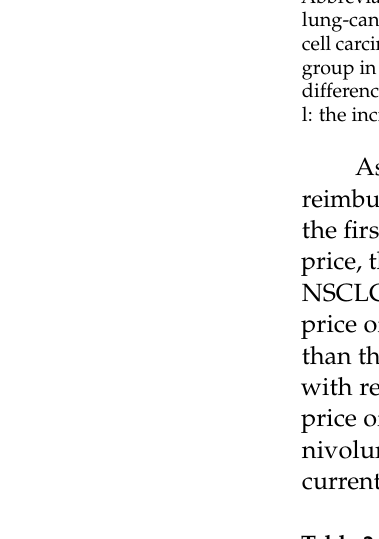
Table 2. Drug price of immunotherapies according to each value-based pricing